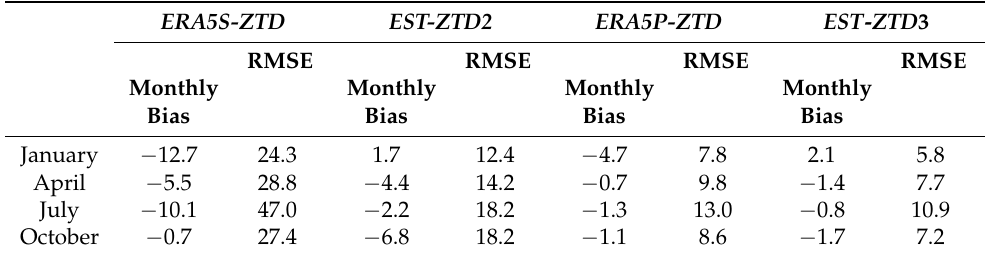
Figure 9. Bias time series of ZTD estimations at the GLSV site in January, April, July, and October of 2018. The four subgraphs on the left refer to the bias time series from ERA5S-ZTD and Scheme 2, and four subgraphs on the right for the ERA5P-ZTD and Scheme 3. Table 5. Monthly bias and RMSE of ZTD estimations from ERA5S-ZTD, EST-ZTD2, ERA5P-ZTD and EST-ZTD3 model at the GLSV site in January, April, July, and October of 2018. Unit is millime-